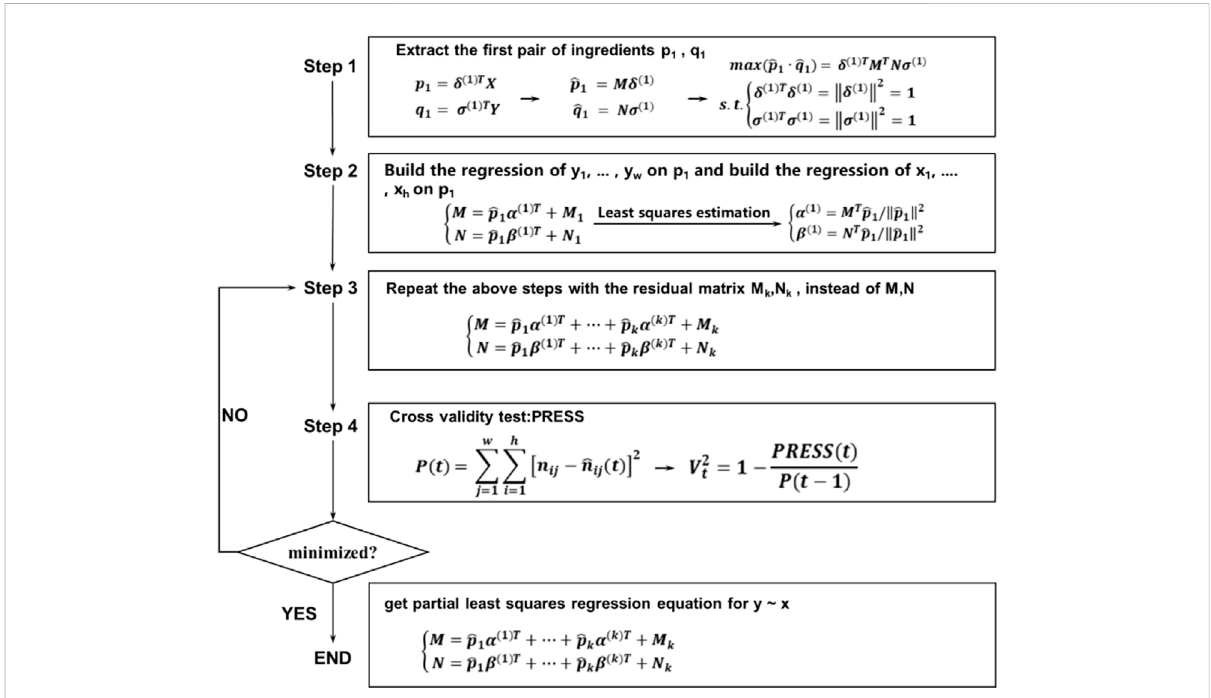
FIGURE 1 Major steps of PLSR calibration. Note: X and Y are the data on environmental variables and soil CO 2 uptake respectively. The corresponding matricesofXandYareMandN,respectively.ThecorrespondingeigenvectorsofMandNare δ and σ ,respectively.Tocalculatethecoef fi cients α and β in the principal components from PLSR, we extract as much variation information as possible from each variable group. This is a conditional extremum problem, which is solved using the Lagrange multiplier